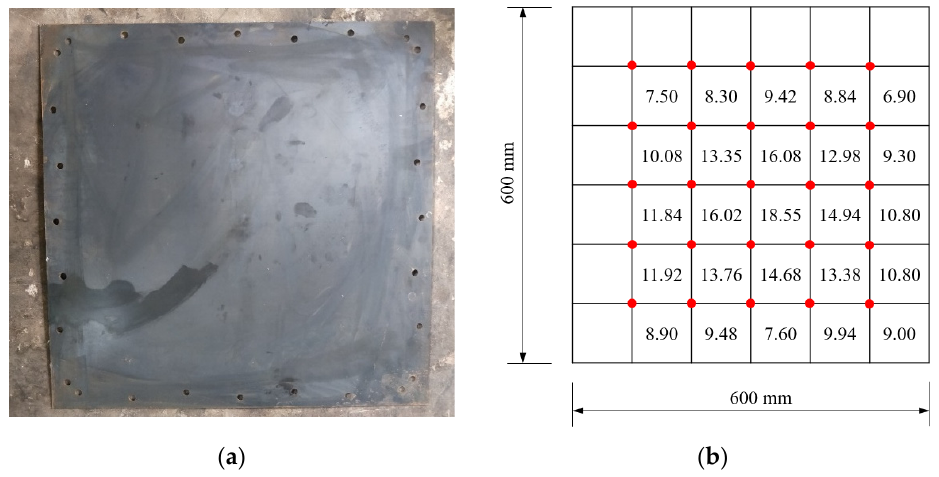
Figure 8. Deformation of the specimen with 2.5 g TNT. ( a ) Specimen after the explosion. ( b ) Deformation details.